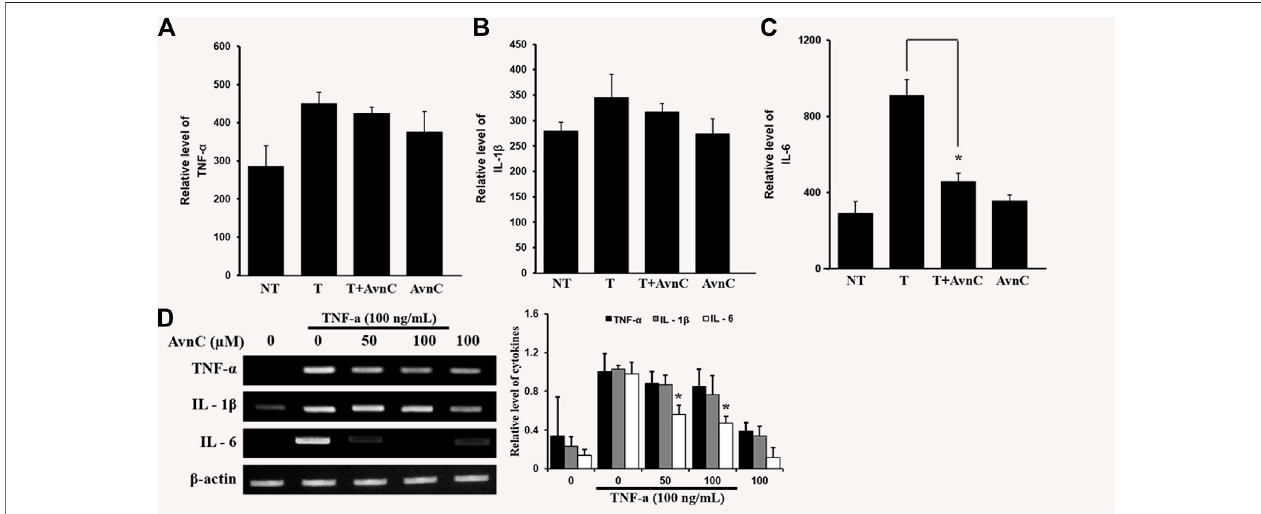
FIGURE4 | EffectsofAvn Con TNF- α -induced cytokines secretion levels ofIL-1 β , IL-6and TNF- α in HASMC cells (A) and (B) were not different in thesecretion of IL-1 β and TNF- α cytokines with treatment by AvnC according to ELISA, but (C) Avn C attenuated TNF- α -induced IL-6 in fl ammatory cytokines. Results shown are representative of three independent experiments. Also, Avn C showed no effect on the total expression level of IL-1 β and TNF- α , but it speci fi cally decreased the expression level of IL-6 in TNF- α -stimulated HASMC cells by RT-PCR analysis (D) . Results are presented was mean ± SEM. * p < 0.05 indicates a signi fi cant difference from TNF- α -treated cells. NT, no treatment; T, TNF- α ; T + AvnC, TNF- α + Avn